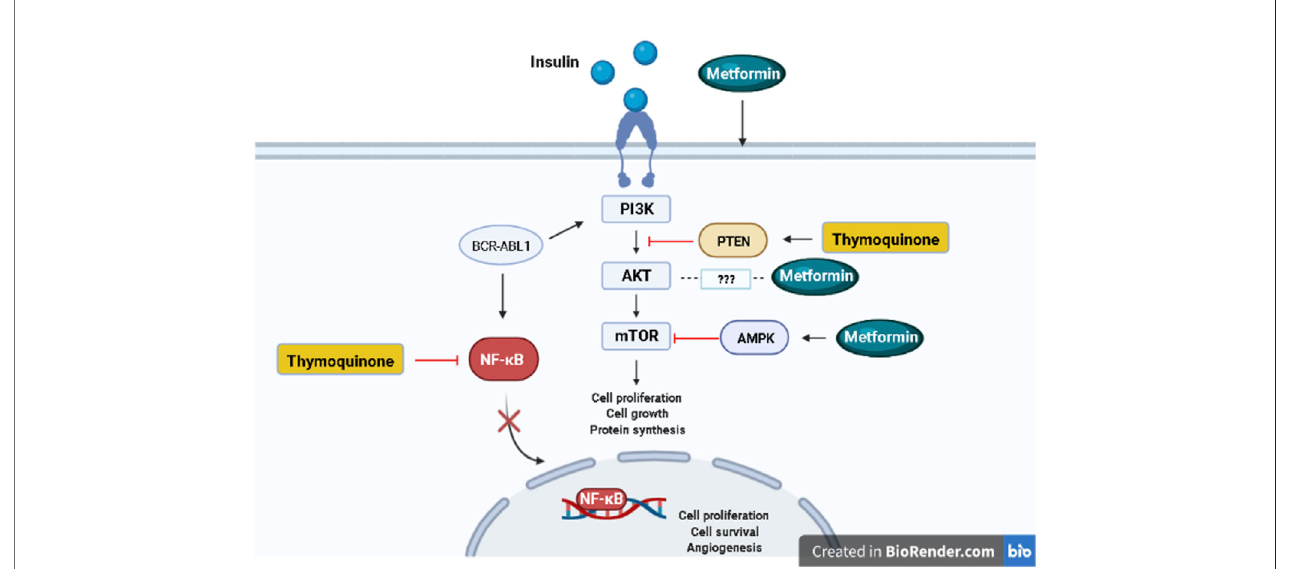
FIGURE 1 | Signaling pathways targeted by metformin and thymoquinone. Created in